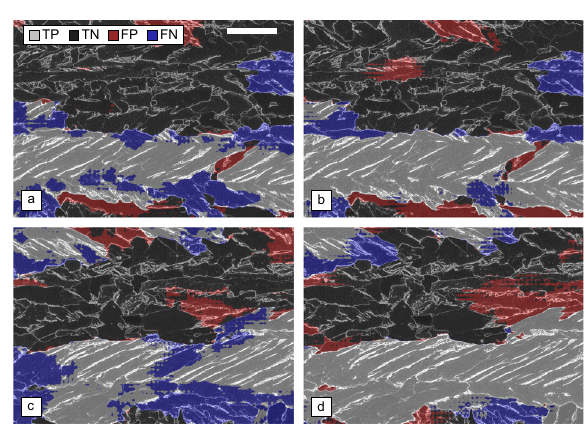
Fig. 3 Predictions on the target 2 test images. The left column ( a ), ( c ) gives the predictions of a DeepLabv2 model trained on the source dataset (cf. experiment T2.10). The right column ( b ), ( d ) give the predictions of a DeepLabv2 model trained with the UDA framework on the source and target 2 datasets (cf. experiment T2.11). TP, TN, FP, and FN stand for true positives, true negatives, false positives, and false negatives, respectively, the positive class being the lath-bainite foreground. The scale bar width is equivalent to 10 μ m.